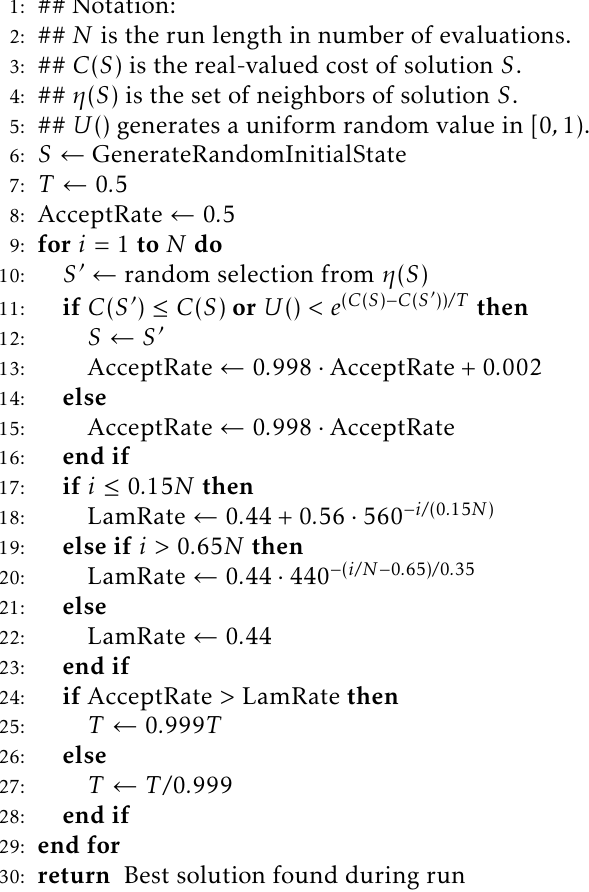
Algorithm 2 Original Modified Lam